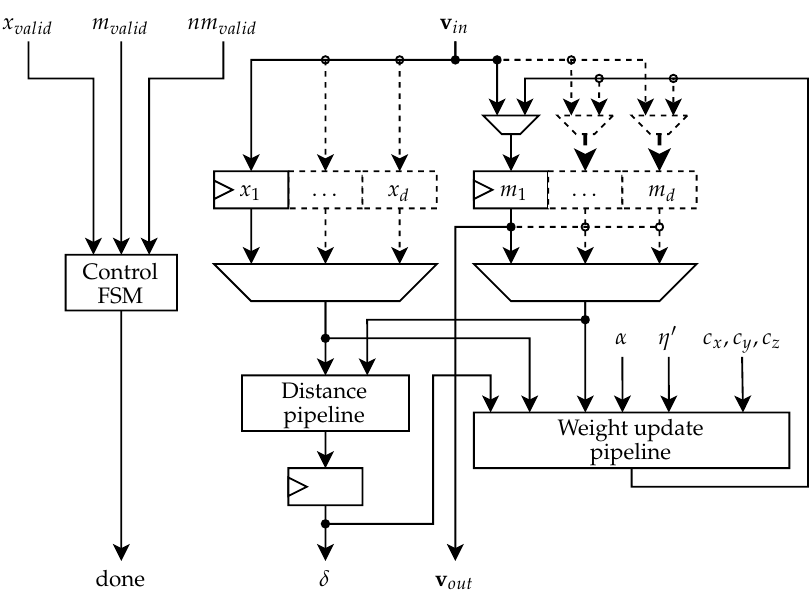
Figure 9. ACSOM unit